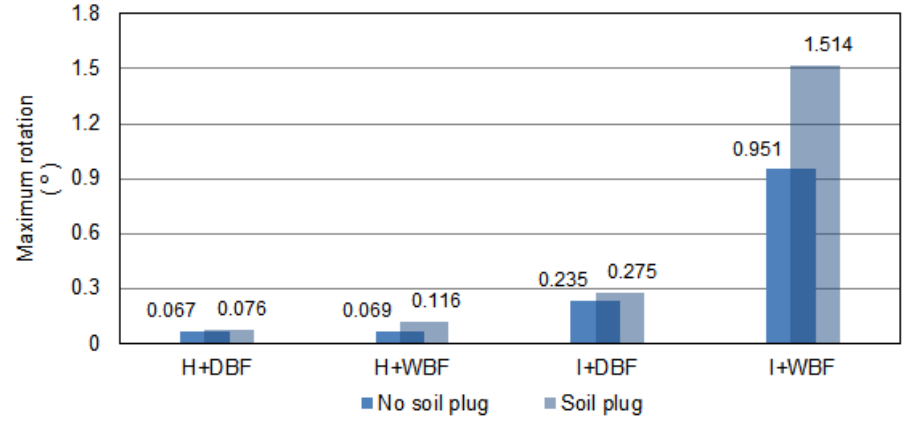
Figure 10. The maximum rotation of bucket foundations in 50% relative density liquefiable seabeds.